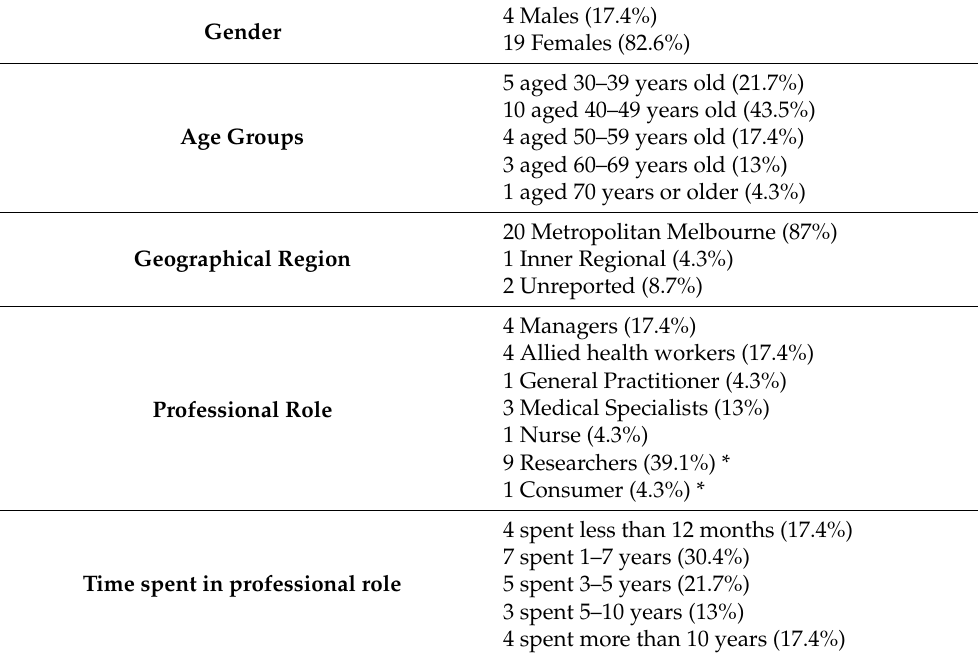
Table 1. Demographics of the co-production team members who completed the ratings.